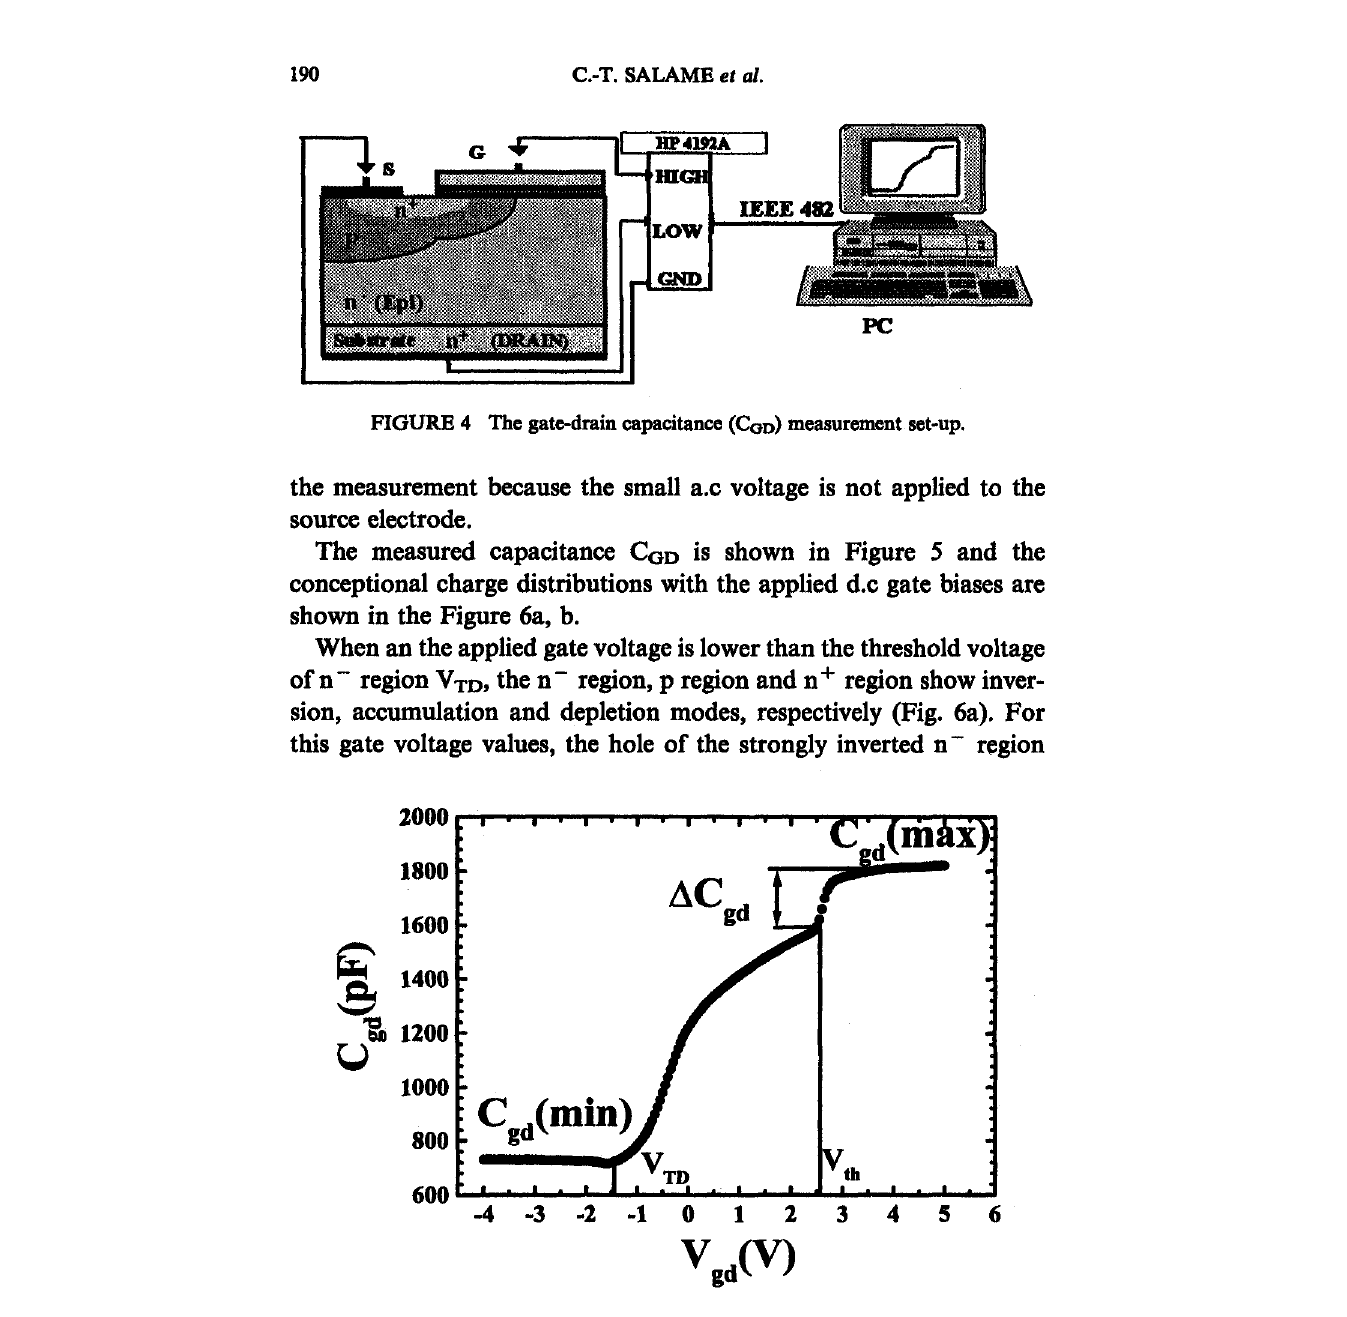
FIGURE 5 The measured gate-drain capacitance curve